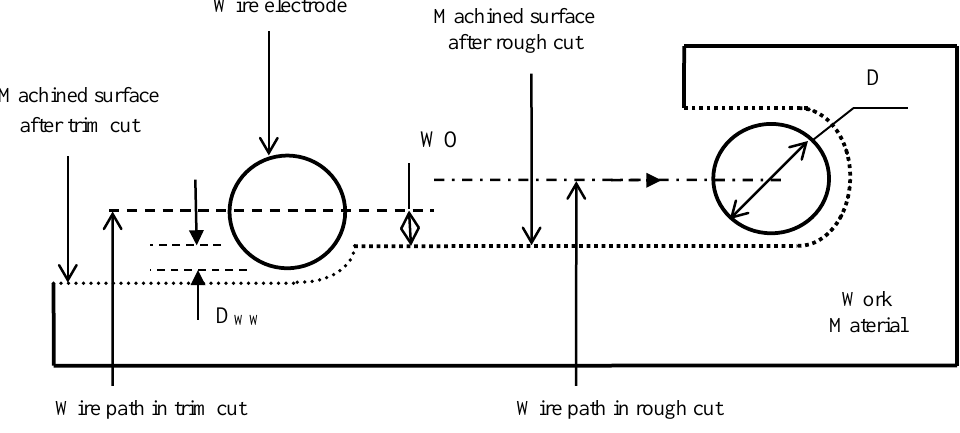
Fig. 1. Terminology used for rough and trim cut in